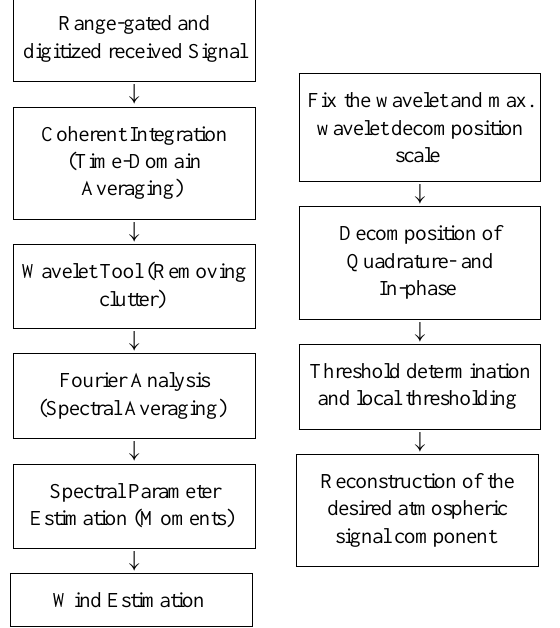
Fig. 5. Left: The flow diagram extended by the wavelet tool. Right: The wavelet algorithm flow diagram.